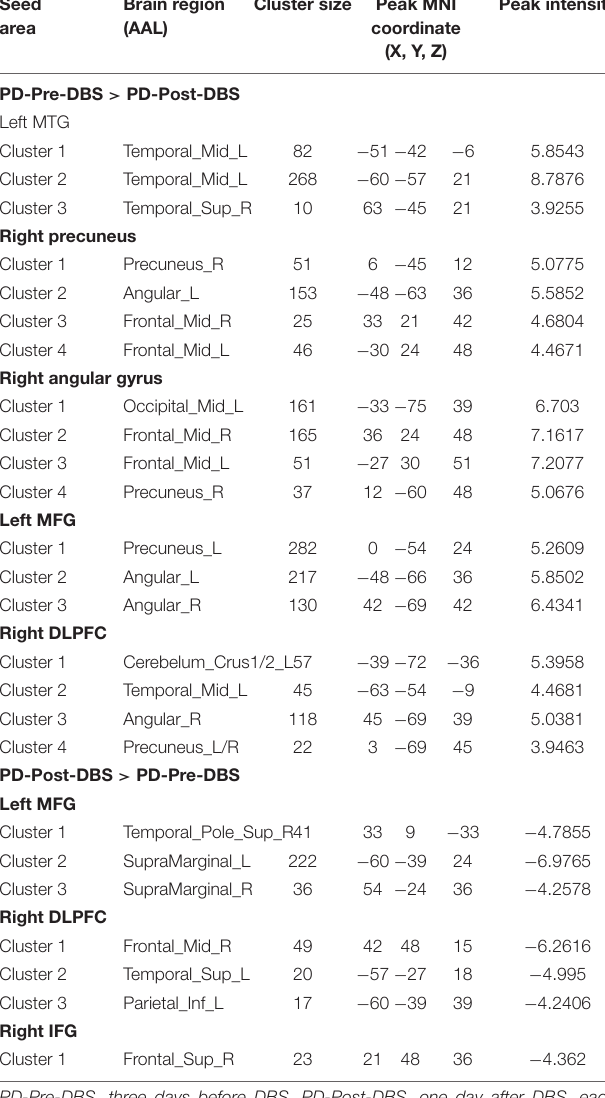
TABLE 3 | Difference in functional connectivity between the PD-Pre-DBS group and the PD-Post-DBS group (voxel p < 0.001, FWE correction with cluster p <